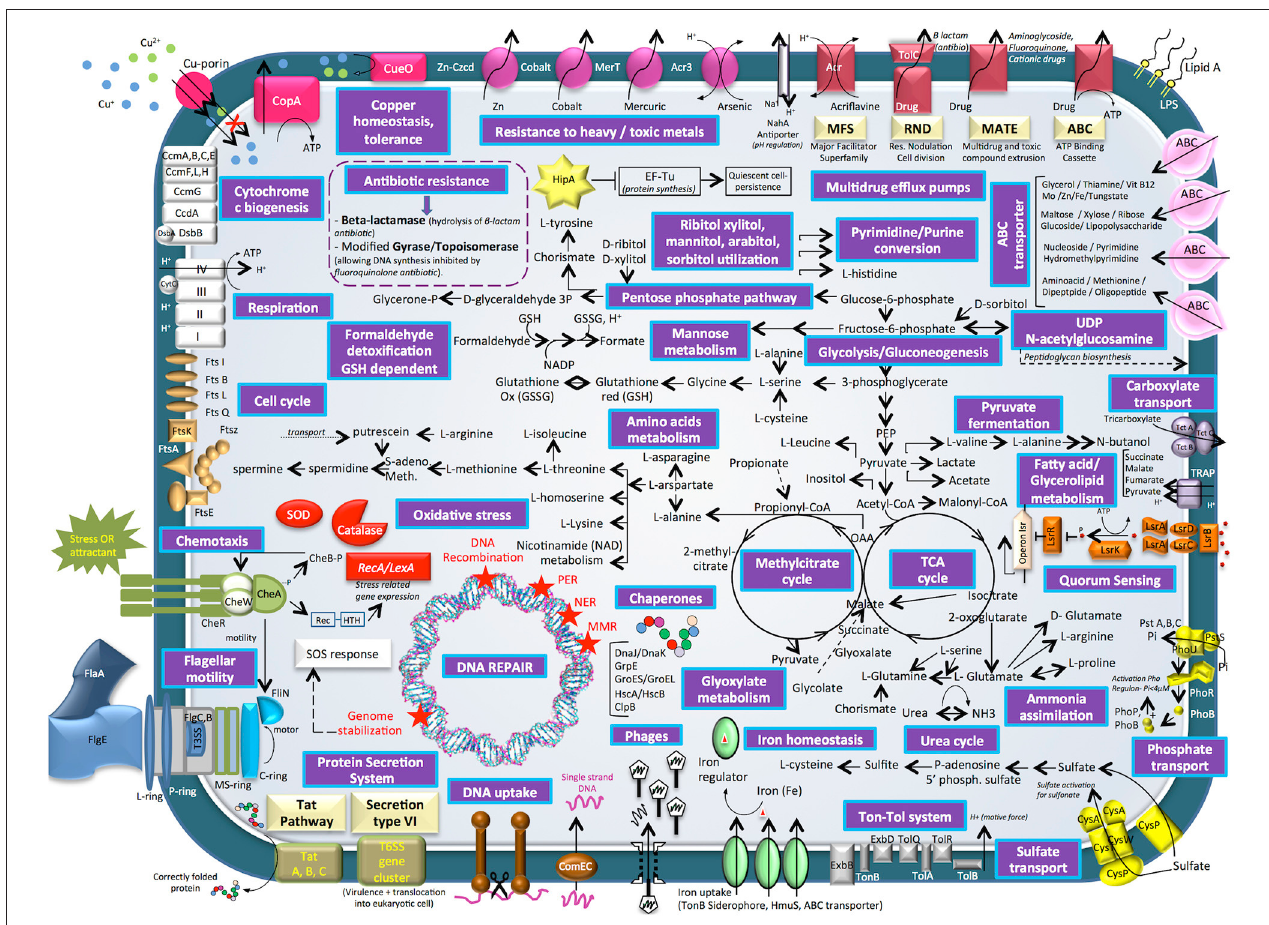
FIGURE 4 | Cell diagram showing the main metabolism pathways of E. mobile BBCC367 obtained from the theoretical